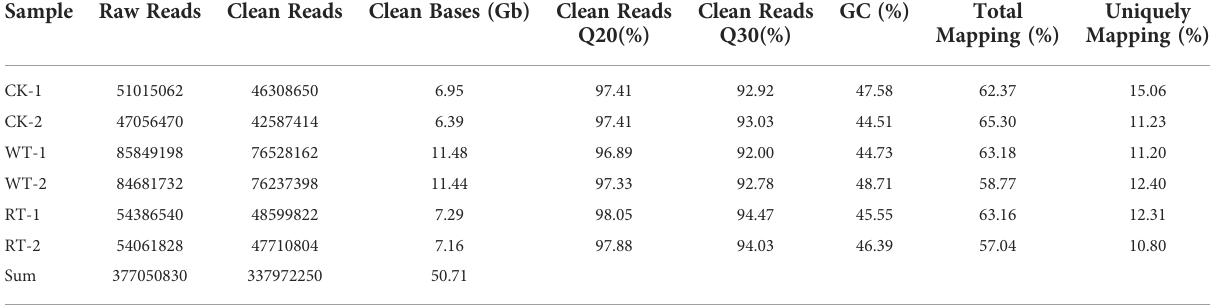
TABLE 2 Information of RNA-seq raw data and clean reads mapped with the reference transcriptome.